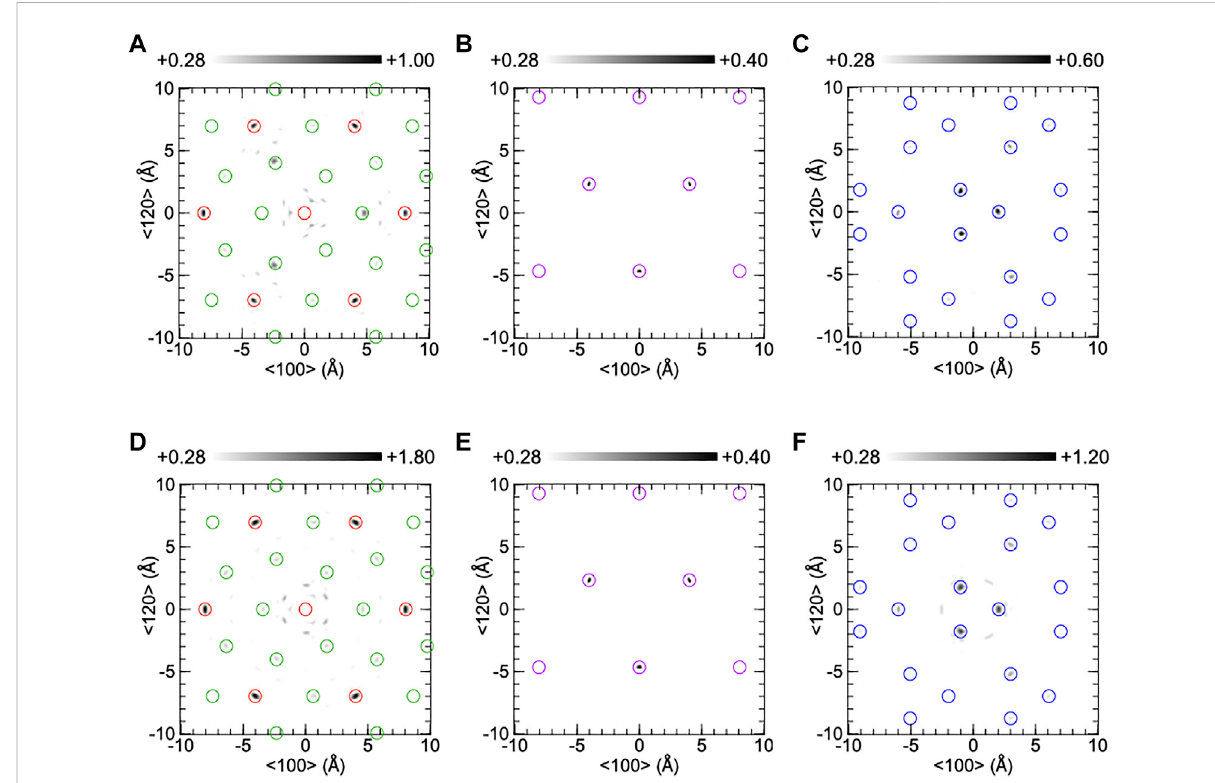
FIGURE 6 Reconstructedatomicimagesonthe(001)planeofaCTGAScrystalatz=0Å (A,D) ,2.24Å (B,E) ,and2.47Å (C,F) .Theupperandlowerpartswere obtained from experiment and simulation, respectively. Red, green, purple, and blue circles indicate the positions of Ta, Ca, Si, and Ga/Al